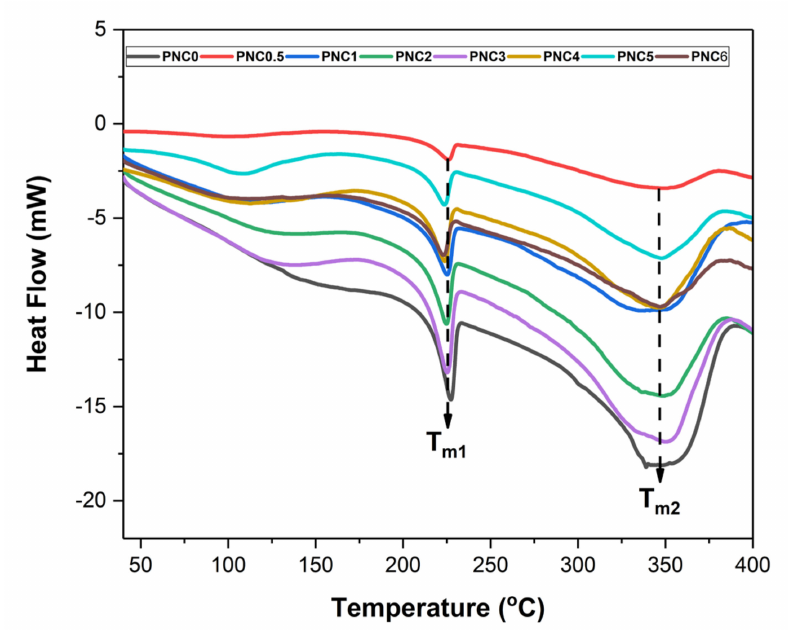
Figure 7. DSC curves of PVA–NCC nanocomposite